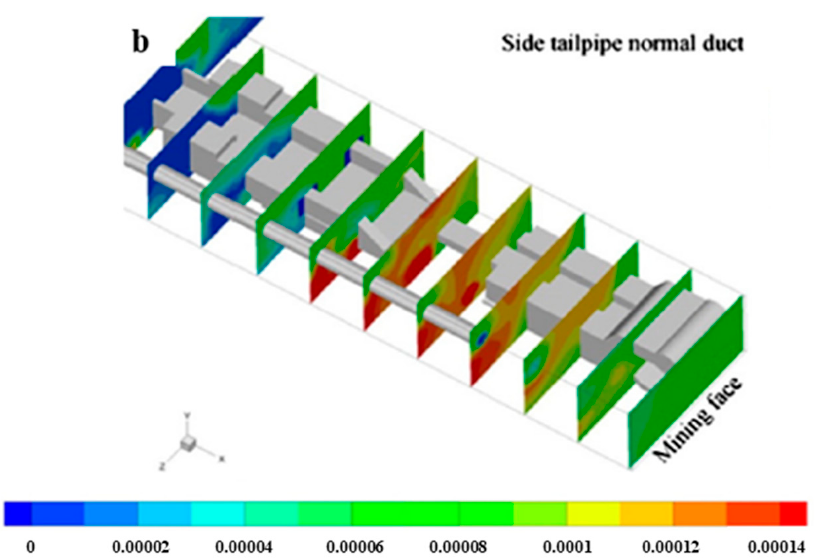
Figure 5. ( a ) Schematics of working area in mine faces with shuttle car, continuous miner, and blow- ing duct ( b ) mass fraction of nitric dioxide at different planes used to compute dispersion of gases [22]. (Adapted with permission from ref. [22]. Copyright 2014 Elsevier B.V.). Xu et al. [23] present CFD results for SF 6 dispersion as a tracer gas in mine tunnels.